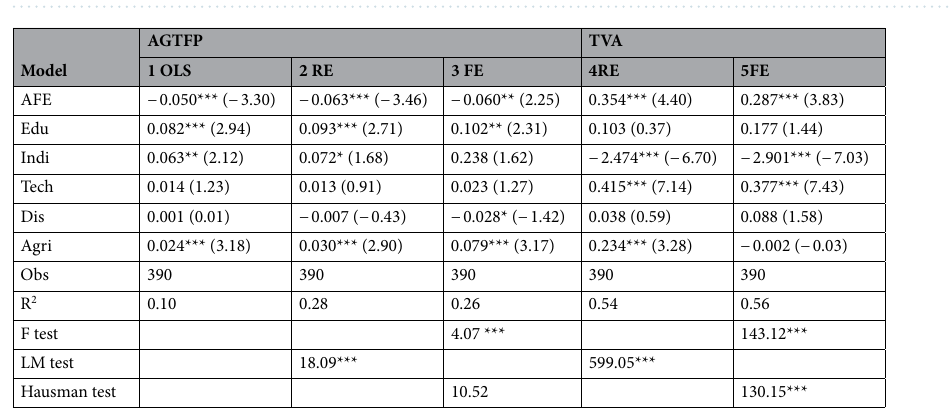
Table 2. Estimation results without spatial interaction effects. *, **, *** indicate significance at the 10%, 5% and 1% level, the standard errors are in parentheses.